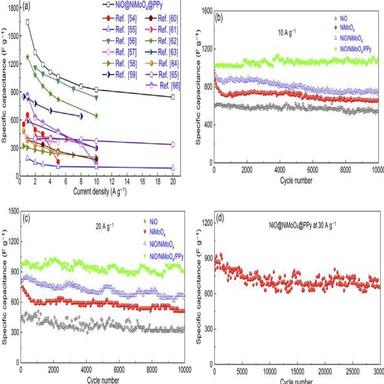
(Color online) GCD characterization of NiO-based composites. (a) Comparison of specific capacitances between this work and other literatures for NiO-based composites, cycling stability of all samples at10 A g1 (b) and 20 A g1 (c); (d) long term cycling stability of NiO@NiMoO4@PPy at 30 A g1 .